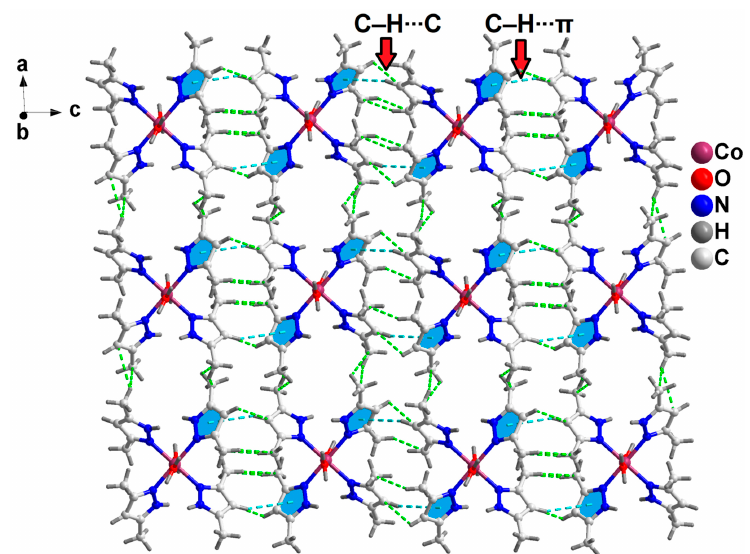
Figure 6. Layered architecture of compound 2 along the crystallographic ac plane assisted by non-covalent C ‒ H···C, C ‒ H··· π